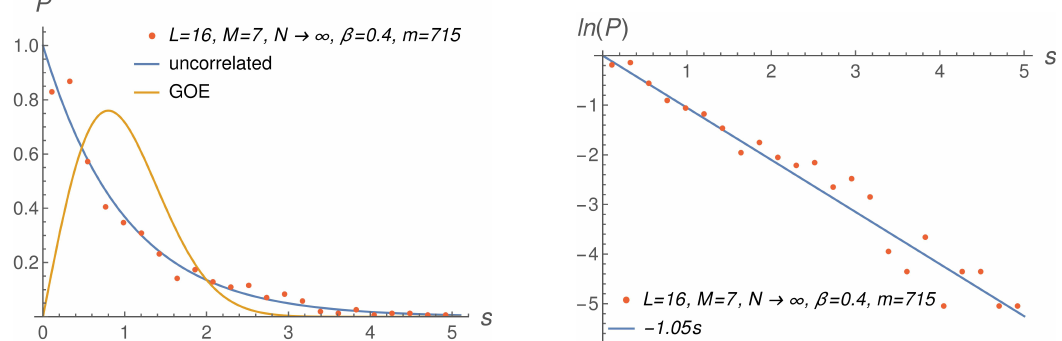
Figure 2: On the left we plot the spacing distribution for the planar β -deformed theory against the expected Poisson distribution of integrable systems. On the right we linearize the distribution and find that the best fit yields a slope equal to